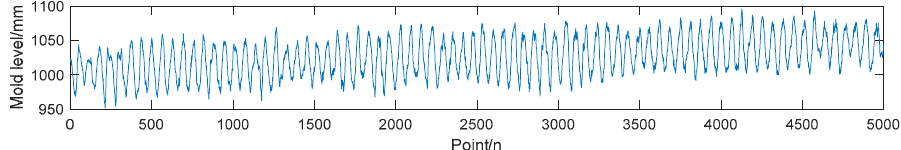
Figure 4. Mold level. The unit of mold level is mm, n is the number of point.